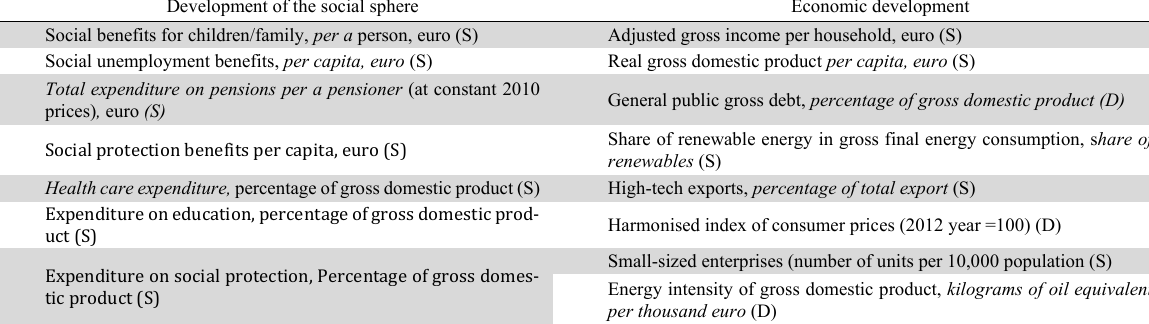
Components and indicators of social and economic development Development of the social sphere Economic development